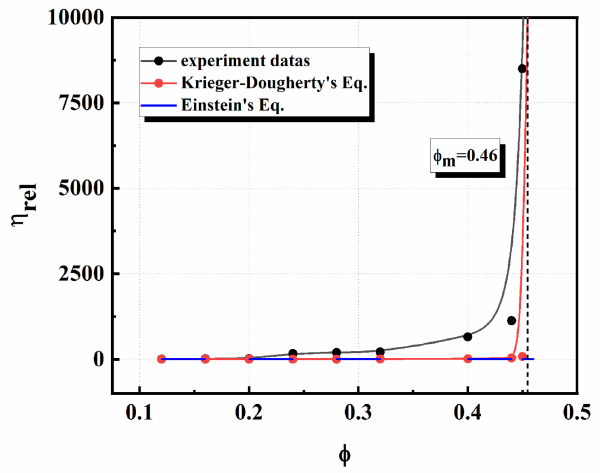
Figure 12. The relative viscosity of the SiC slurry as a function of solids loading determined by di ff erent